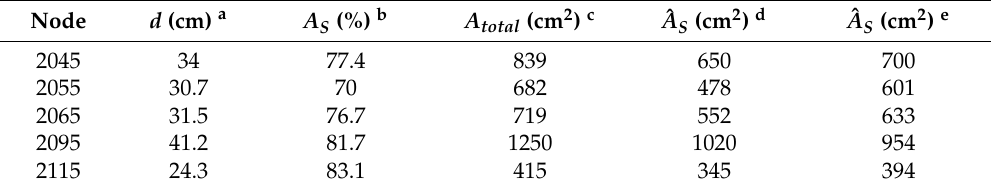
Table 2. Comparison of silver maple (Acer saccharinum) sapwood area from [66] measurements and Equation (6) estimations in site 2 of the ASWP network. Table 3. A S /A G calculations based on the field survey within the three survey regions in site 2 of the ASWP site.